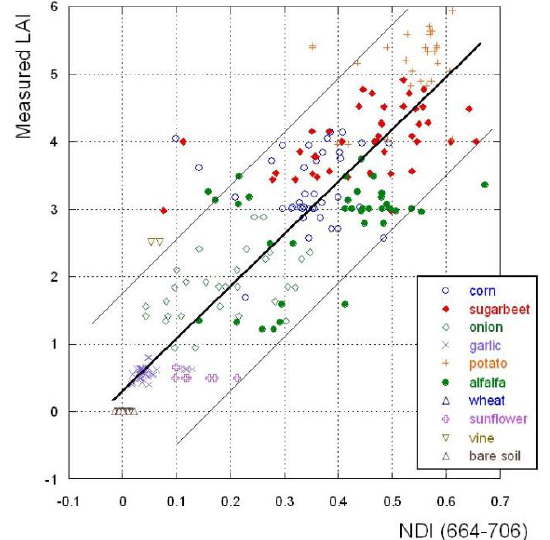
Figure 1. Measured LAI against NDI from 664 and 706 nm from CHRIS data. Central line corresponds to Equation 7 and the finest lines plus and minus twice the standard